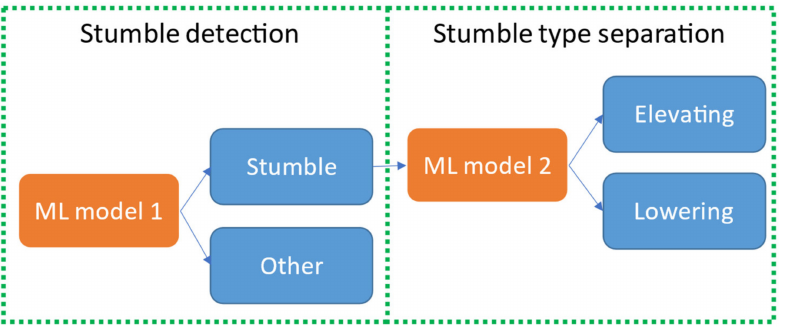
Figure 7. Two binary machine learning models in series.